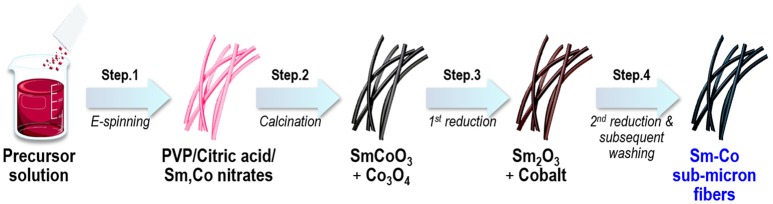
Schematic drawing of the process flow.